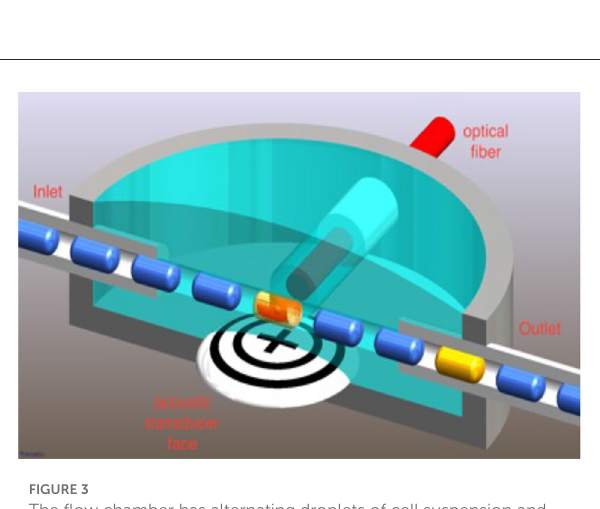
FIGURE3 The flow chamber has alternating droplets of cell suspension and mineral oil so that detected cells are sequestered for downstream